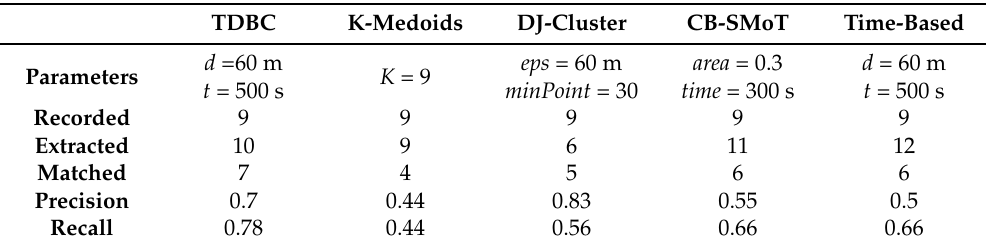
Table 3. Results of different cluster algorithms for Dataset